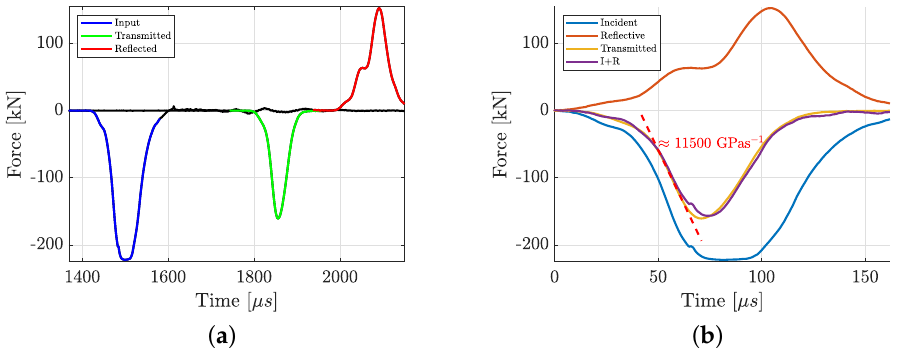
Figure 3. Example pulses from the dynamic uniaxial compression test of diorite, which is representa- tive for all the compressive testing conducted in this study. The incident, transmitted and reflective force waves ( a ) and the validation of force equilibrium in the sample by comparing the pulses ( b